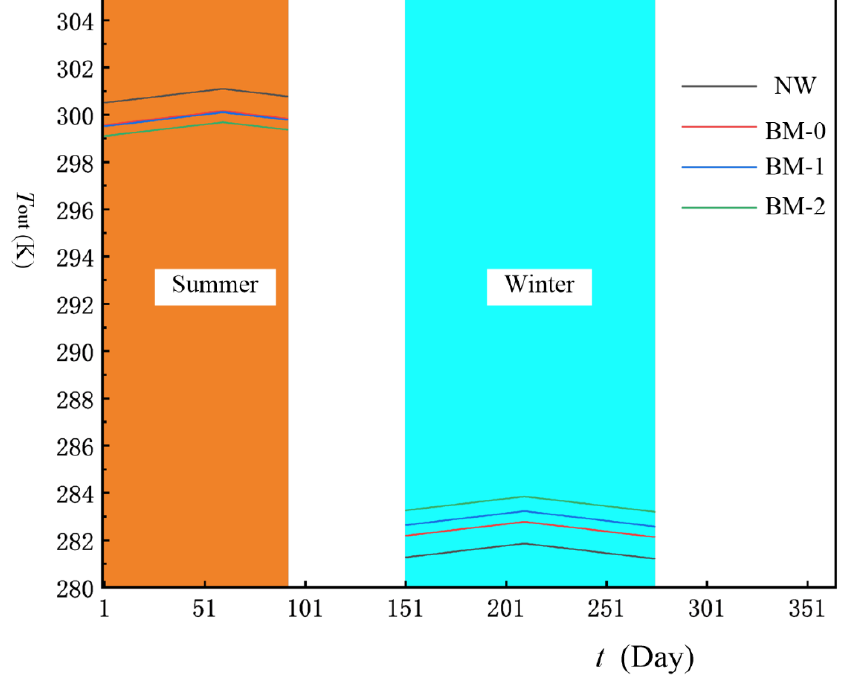
Figure 9. Outlet water temperatures of the U pipe with time. Table 4. Parameters of the underground heat exchanger.